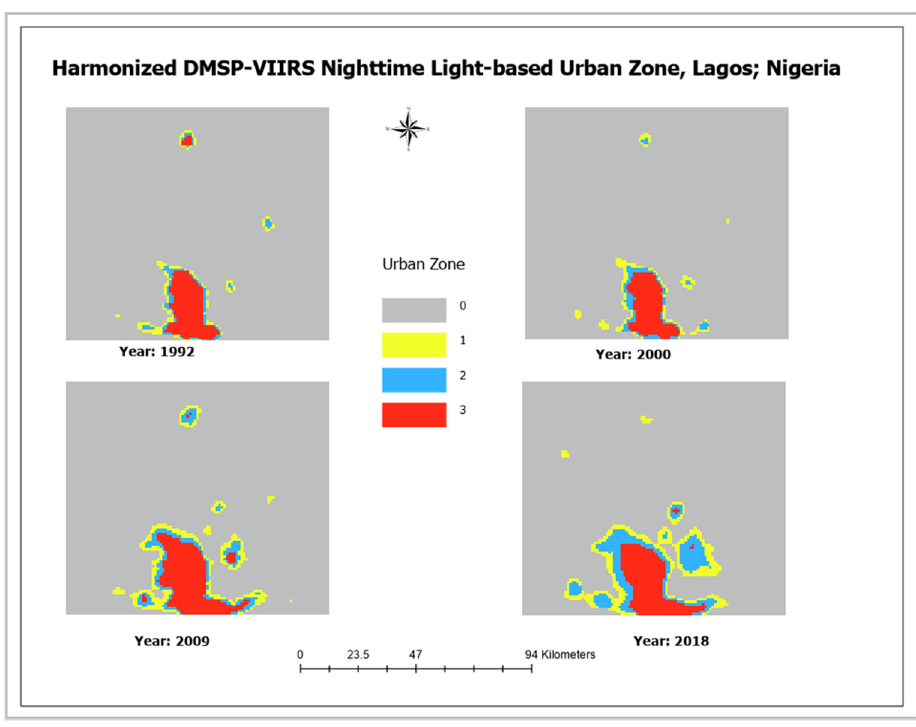
Figure 5. Nighttime light-based zones over study area.